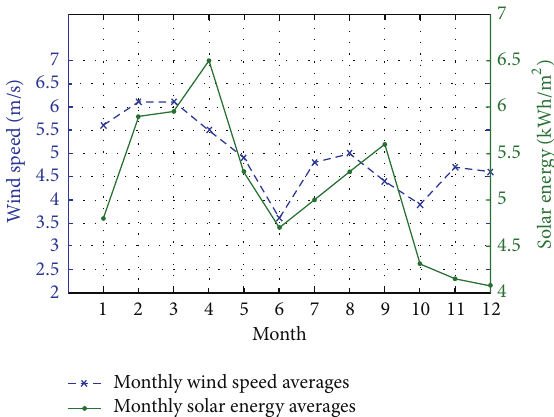
Figure 5: Average monthly solar energy and wind speed for Sohar.